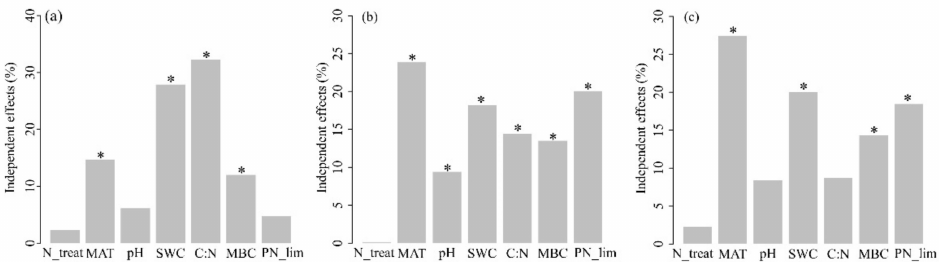
Figure 4. The relative influence of environmental factors on the fungal alpha diversity ( a ), fungal community structures ( b ), and fungal functional compositions ( c ) revealed by hierarchical partitioning analysis. N_treat: N treatments, MAT: mean annual temperature, pH: soil pH, SWC: soil water